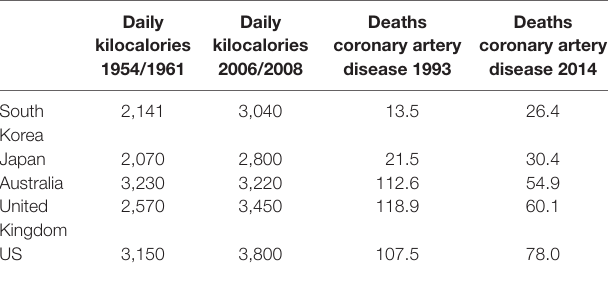
TABle 2 | Asian (South Korea, Japan) and western (Australia, United Kingdom, US) apparent daily per capita food consumption in